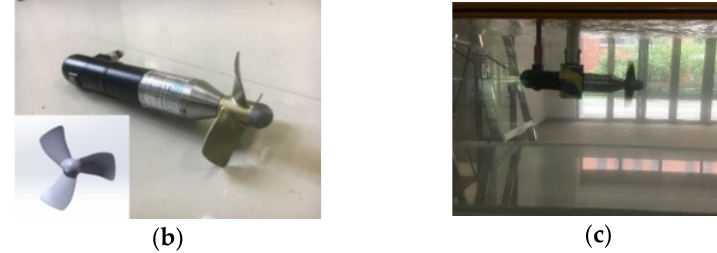
Figure 19. The equipment of propeller thrust test, the thrust test bracket ( a ), Whale715 propeller with the electric motor ( b ), and the combination of the test system ( c ).